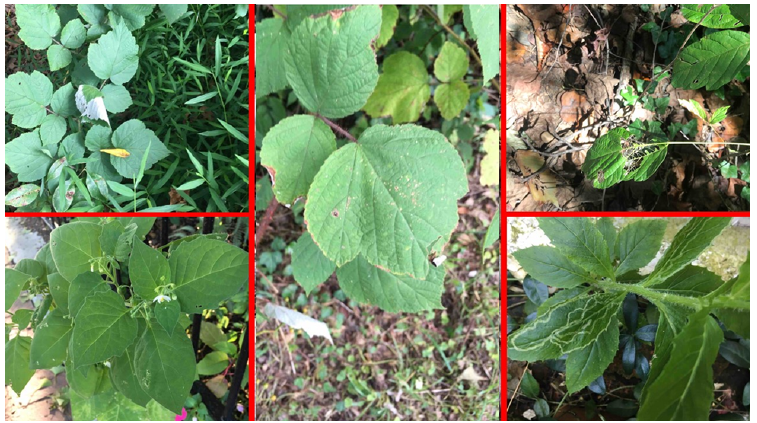
Figure 12. Examples of plants erroneously identified as lambsquarters by users from the DMV, 1 September 2019. Courtesy of Brianna Posadas.